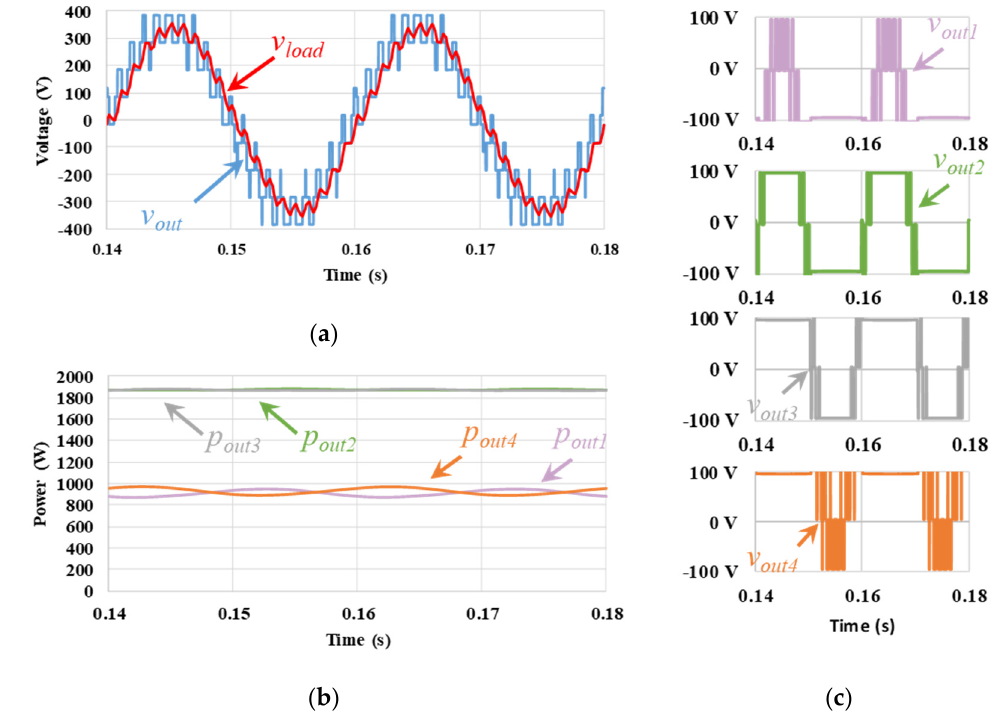
Figure 18. Simulation results of the balanced APOD PWM technique: ( a ) output voltage of the cascaded MLC, v out , and load voltage, v load ; ( b ) output power on each submodule ( p out1 , p out2 , p out3 , p out4 ); ( c ) output voltage on each submodule ( v out1 , v out2 , v out3 , v out4 ).